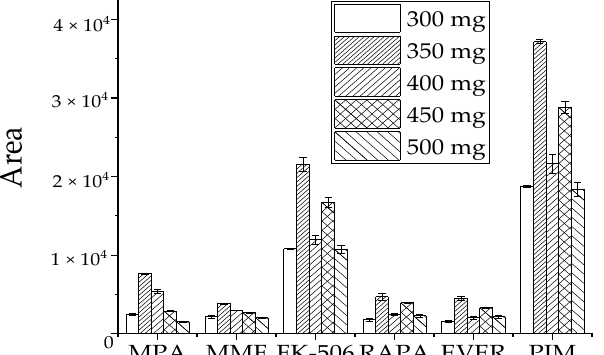
Figure 4. Effect of MgSO4 dosage on recovery peak area of target analyte.